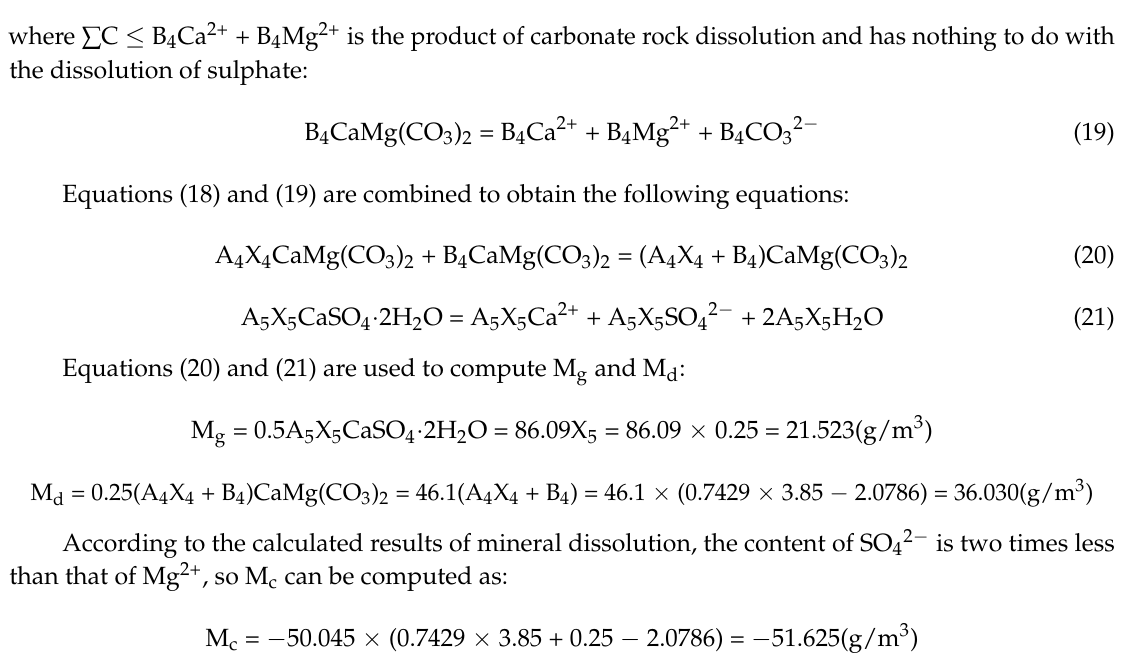
Figure 4. The relationship plots of Ca 2+ vs. SO 42 − and Mg 2+ vs. HCO 3 − .